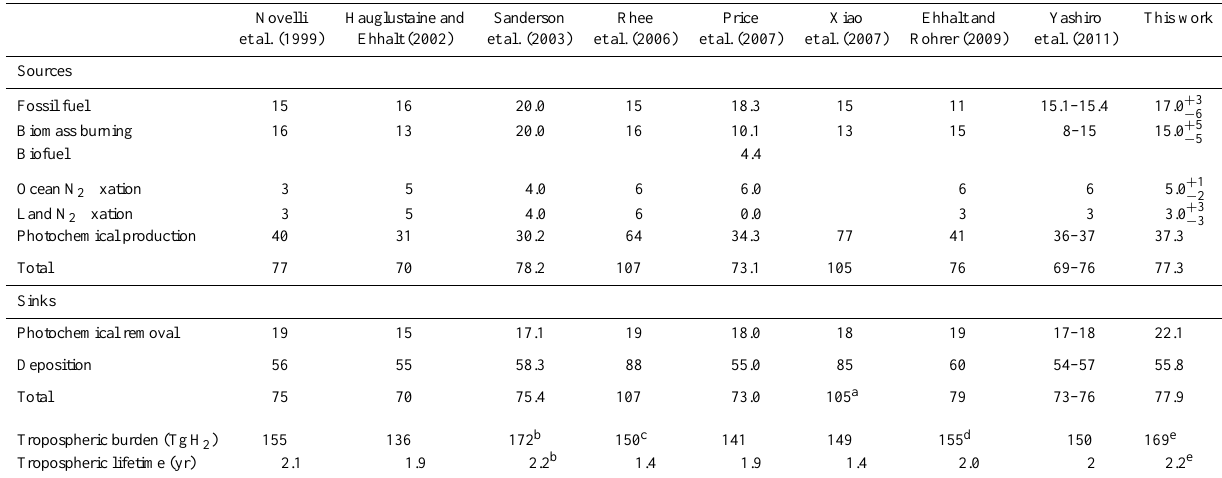
Table 1. Global budget of H 2 from the TM5 reference model run (numbers in TgH 2 per year). Novelli Hauglustaine and Sanderson Rhee Price Xiao Ehhalt and Yashiro This work et al. (1999) Ehhalt (2002) et al. (2003) et al. (2006) et al. (2007) et al. (2007) Rohrer (2009) et al.